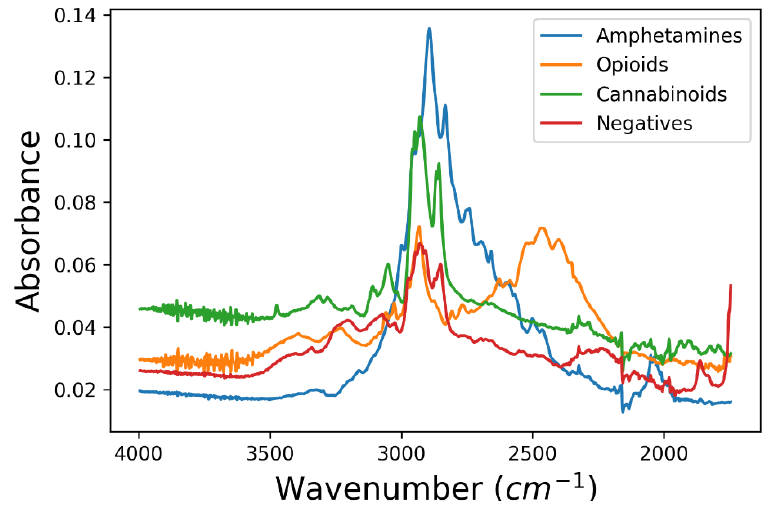
Figure 1. Mean ATR-FTIR spectrum calculated for the amphetamines (blue), opioids (orange), cannabinoids (green), and negatives (red) included in the database.